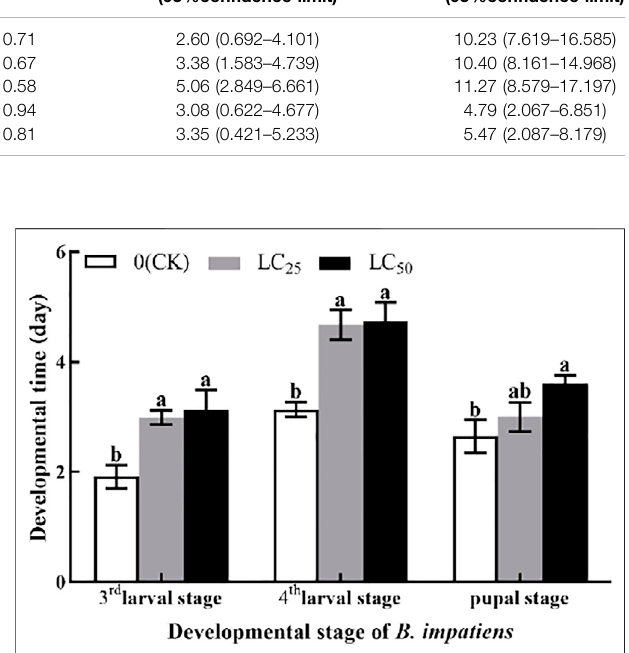
TABLE 1 | Toxicity of the AITC fumigation method to substages of B. impatiens . Substage Toxicity regression equation